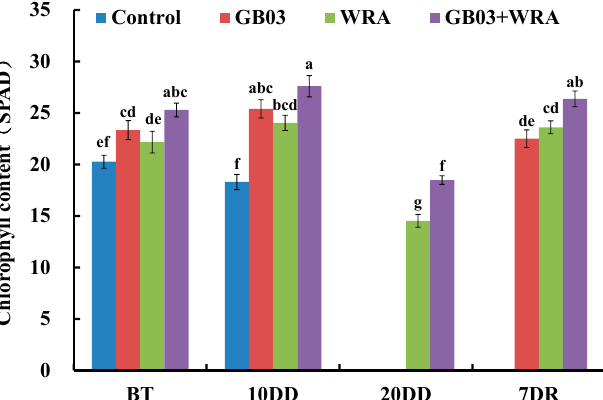
Figure 5. Effects of GB03, water retaining agent (WRA), or the combination of GB03+WRA on leaf chlorophyll content of ryegrass. BT, before treatment (20-day-old seedling); 10DD, 10-day natural drought; 20DD, 20-day natural drought; 7DR, 7 days after rewatering. Values are means and bars indicate SEs ( n = 12). Columns with different letters indicate significant differences among treatments at p < 0.05 (ANOVA and Duncan’s post-hoc multiple comparison test).